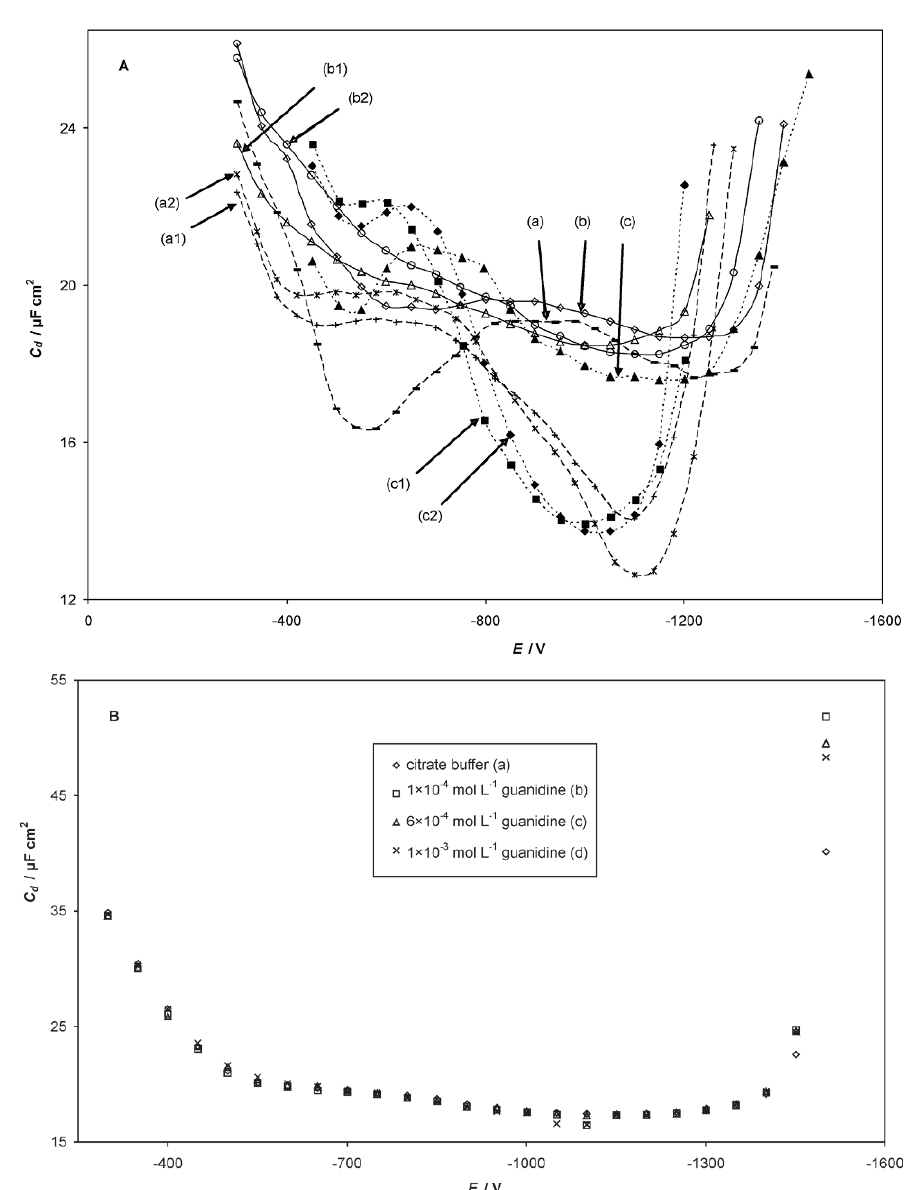
Figure 4. (A) The differential capacity curves of double layer interface (a) Hg/phosphate-citrate buffer (pH 2.35), (b) Hg/phosphate-citrate buffer (pH 2.96), (c) Hg/citrate buffer (pH 2) in the presence of (a1) 5×10 -5 mol L -1 , (a2) 5×10 -4 mol L -1 of ganciclovir [8], (b1) 1×10 -4 mol L -1 , (b2) 2×10 -4 mol L -1 of GTA [26] and (c1) 8×10 -5 mol L -1 , (c2) 2×10 -4 mol L -1 of GTAMITU [26]. (B) The differencial capacity curves of double layer interface (a) Hg/citrate buffer, (pH 2.96) in the presence of (b) 1×10 -4 mol L -1 , (c) 6×10 -4 mol L -1 , (d) 1×10 -3 mol L -1 concentrations of